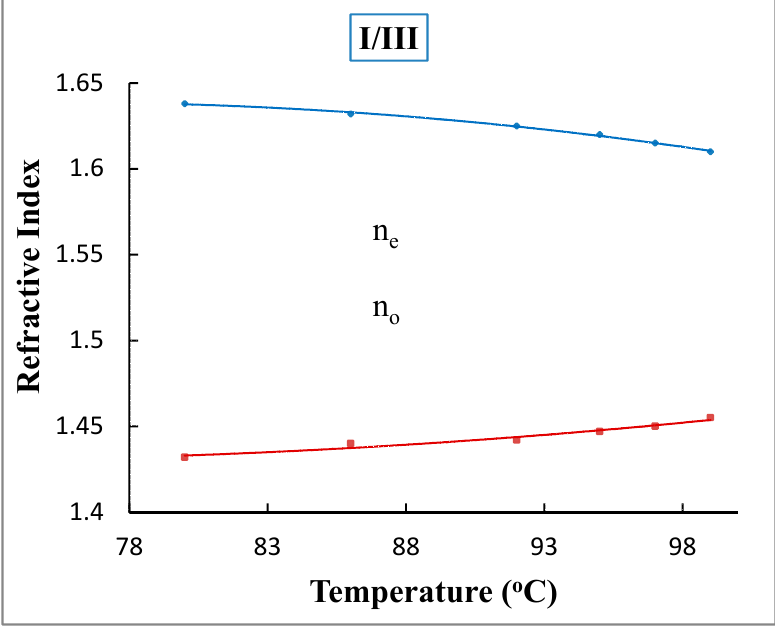
Figure 9. Dependence temperature of refractive indices ( (cid:4) ) n o and ( (cid:7) ) n e for the complex I / III at 543 nm.